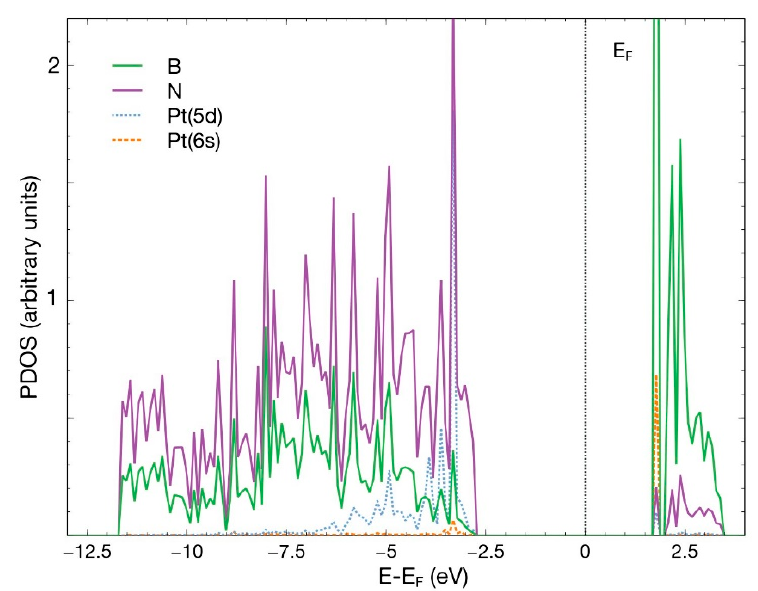
Figure 17. PDOS for the Pt atom chemisorbed on an N-vacancy site of the hBN surface. Interaction between CO 2 and the hBN Surface + Pt in an N Vacancy The final case considered saw no interaction between the CO 2 molecule and the surface. The MD run was 1894 steps long. We show the initial and final configurations in Figure 18. Table 1 summarizes the absorption energies or lack of interaction of the eight cases considered in this work.